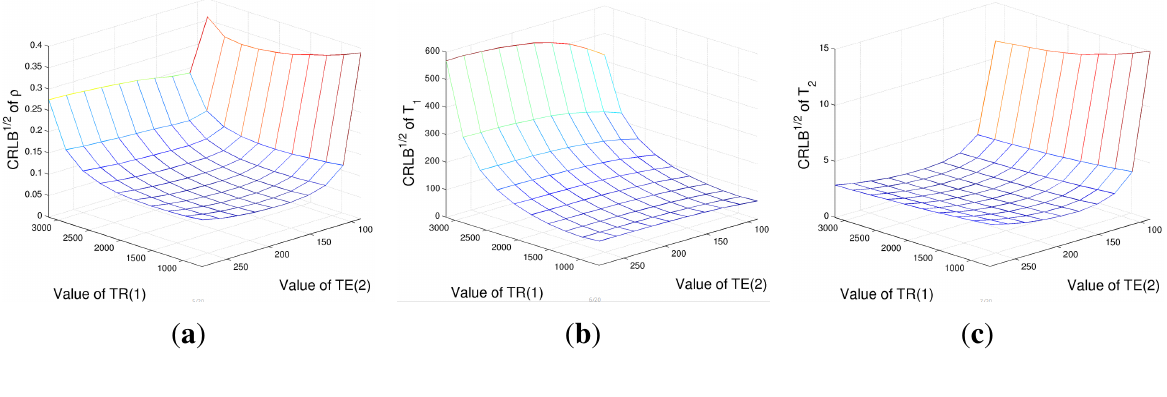
Figure 3. The square root of the CRLB of proton density ρ ( a ), T T relaxation time ( c ) for different combinations of T 2 T = 1 , 600 ms and T 1